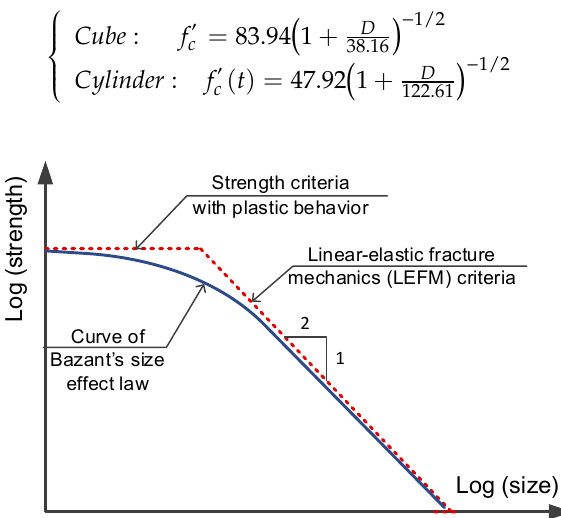
Figure 13. Describing Bažant’s size effect law on strength.